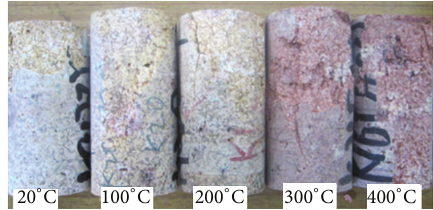
Figure 2: Rock samples correlation under different temperature.